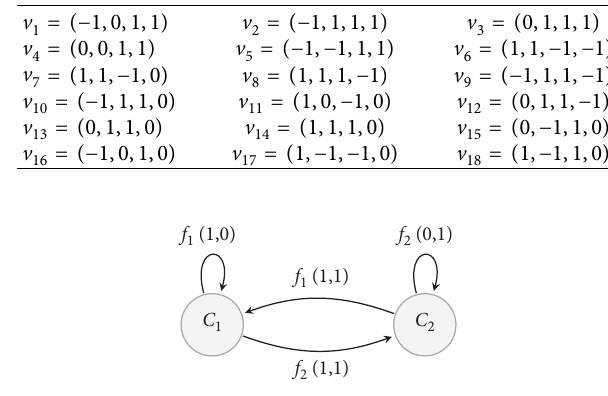
Figure 1: General ecological graph, where two emergent species, C and C , interact with local ftness functions and both species 1 2